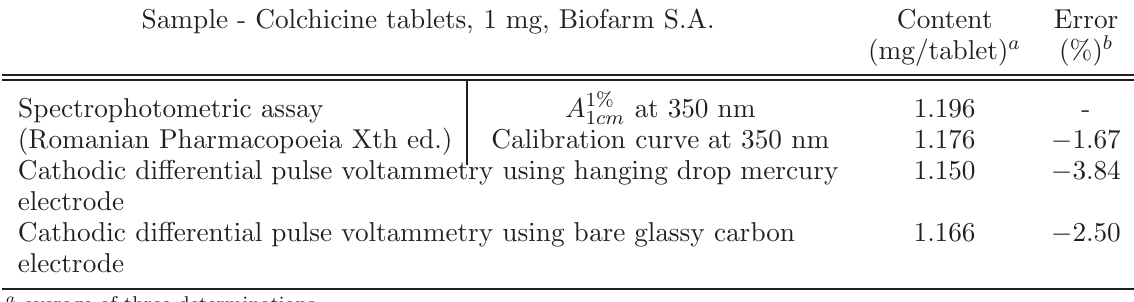
Table 5 Cathodic differential pulse voltammetric calibration curve parameters for colchicine using the three different types of